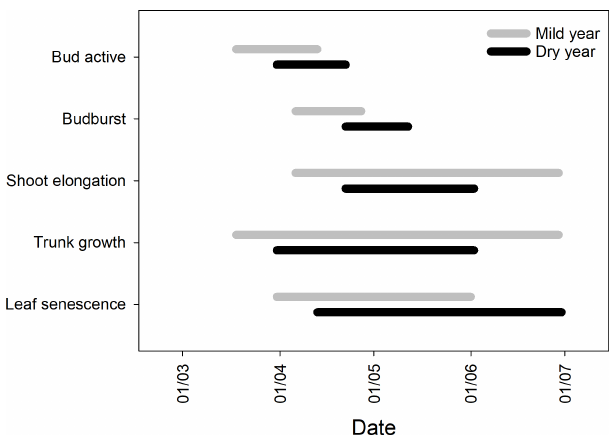
Figure 2. Timing of the onset and cessation of bud development (bud active), budburst, shoot elongation, trunk growth, and leaf senescence in the 2 contrasting years. The bars represent the du- ration of each phenophase from the first to the last observation, in spring ( n = 15). Significant differences between years in the timing and duration of the different phenophases are shown in Table